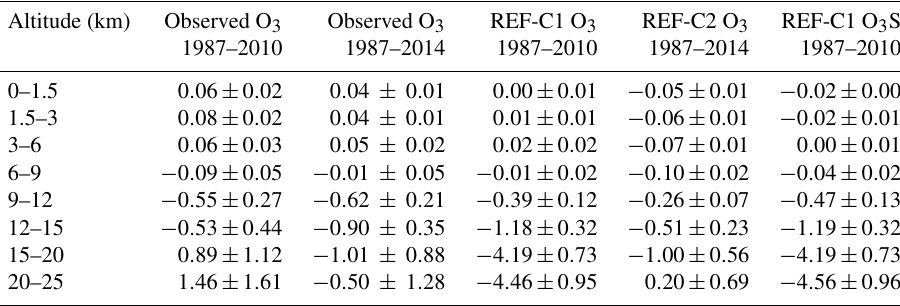
Table 4. Observed and simulated trends in O 3 and O 3 S anomalies ( ± 1 standard error) at Lauder, over the periods of 1987–2010 and 1987– 2014. Units are ppbvyear − 1